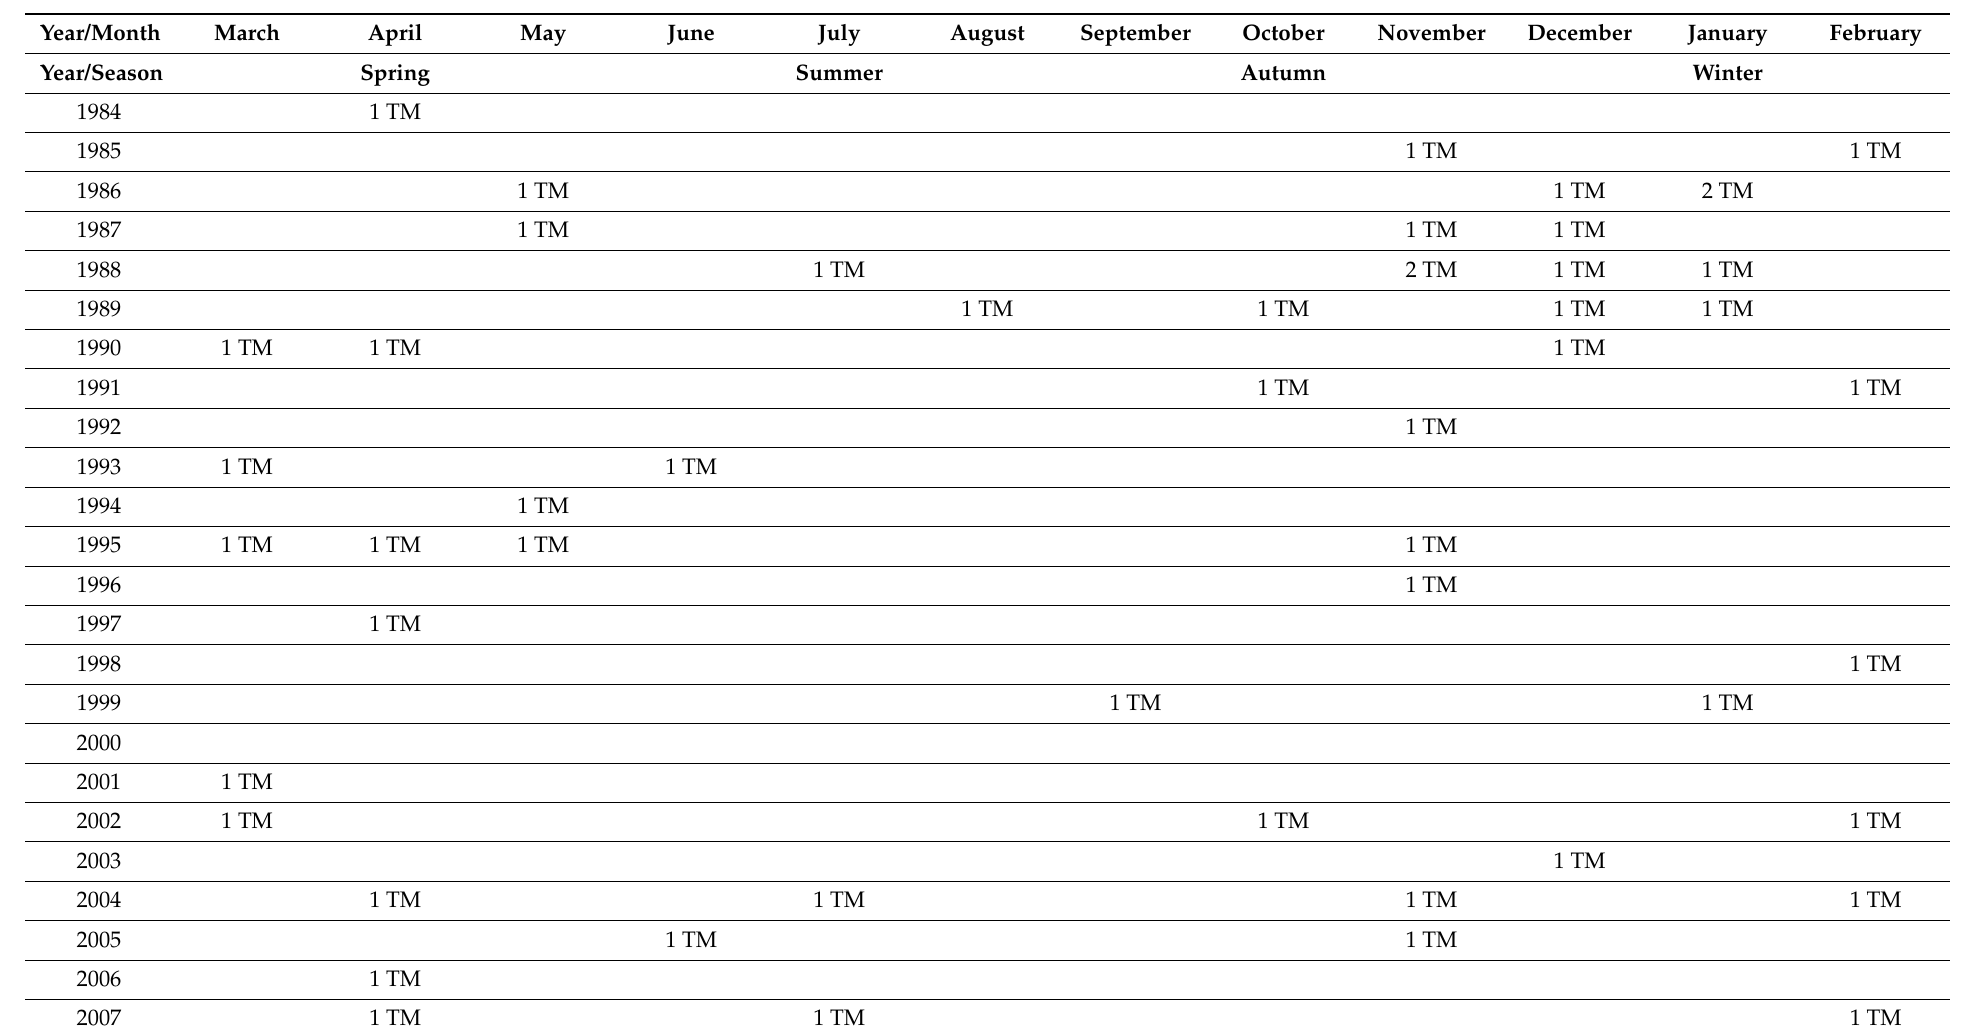
Table A1. Landsat imagery acquired for shoreline extraction in Chongming